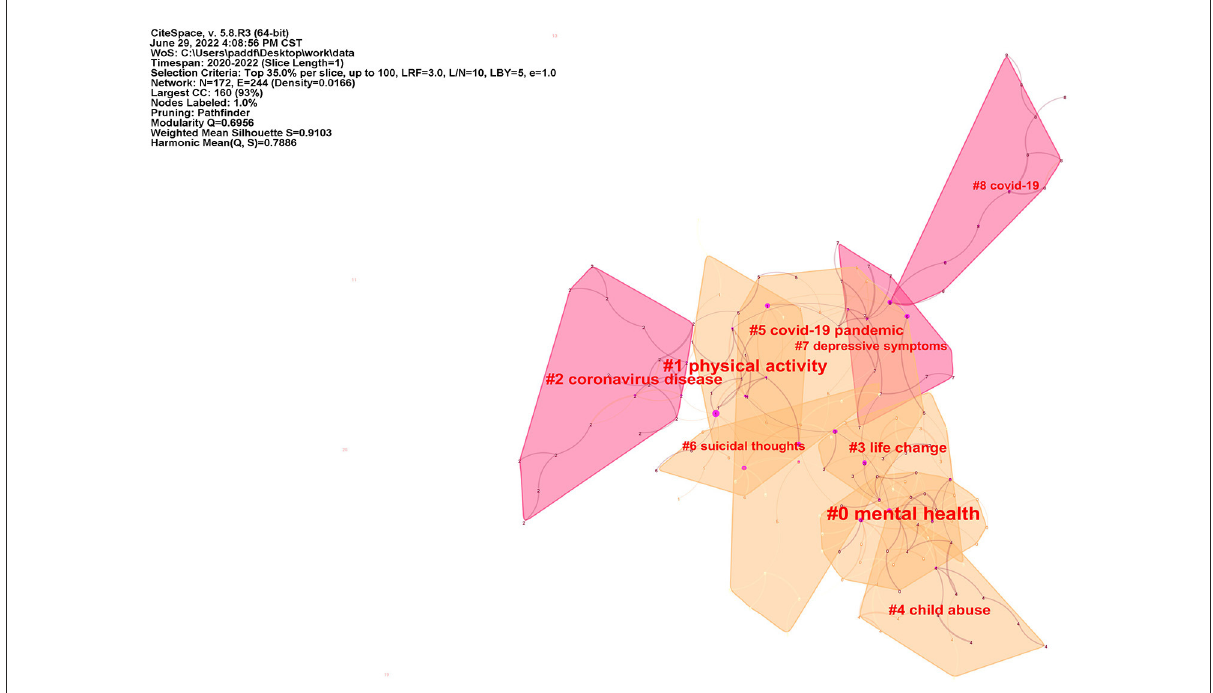
FIGURE7 Cluster of co-citation document network.